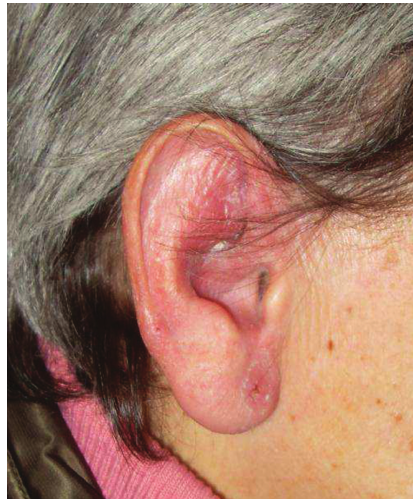
Figure 3: Swelling with features of chondritis and crusted lesions in the right ear.